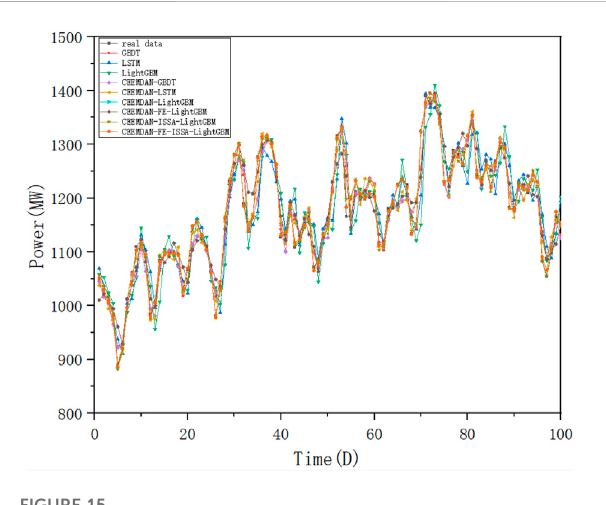
FIGURE 15 Case 2 graph of this paper ’ s model versus a single model.